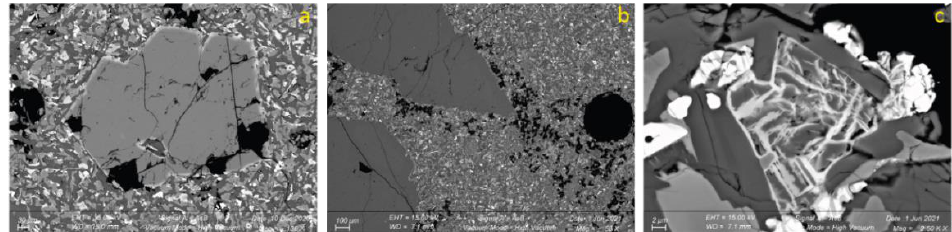
Figure 12. DJI-4-13 SEM pictures in AsB mode displaying ( a ) Fe zonation at the edges of macroscopic olivines and Fe-Ti-rich oxides in the matrix; ( b ) concentration of porosity along and behind centimeter-scale plagioclase minerals, with zones of Fe enrichment textures in olivines; ( c ) flame-like bodies of hematite in an Mg-olivine close to the area of porosity.